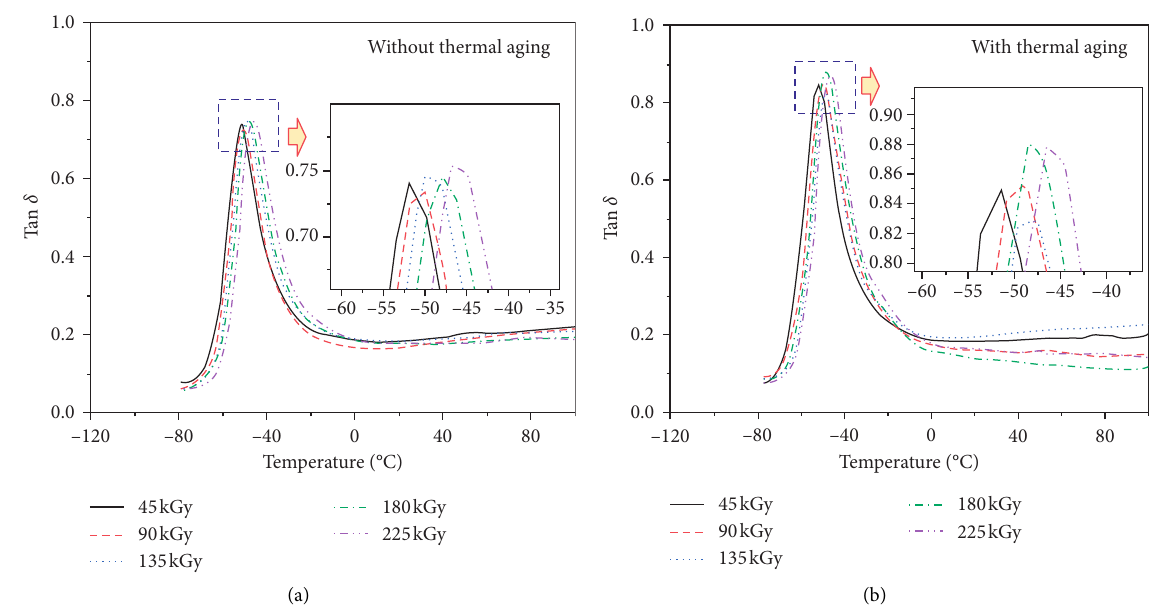
Figure 4: The tan δ of non-aged and aged BR/NR blends at different radiation